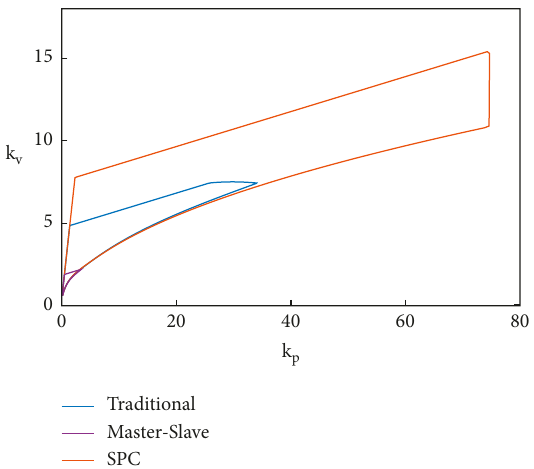
6: D -region in the parameter